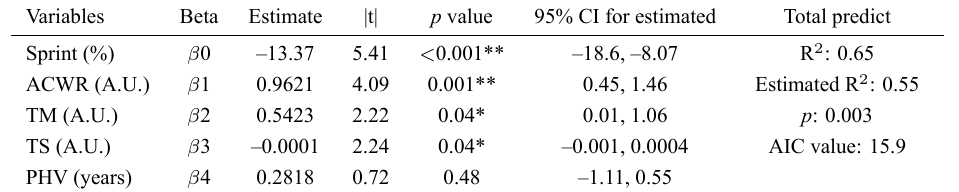
Table 3. Multiple linear regression analysis: percentage of change in sprint with workload and